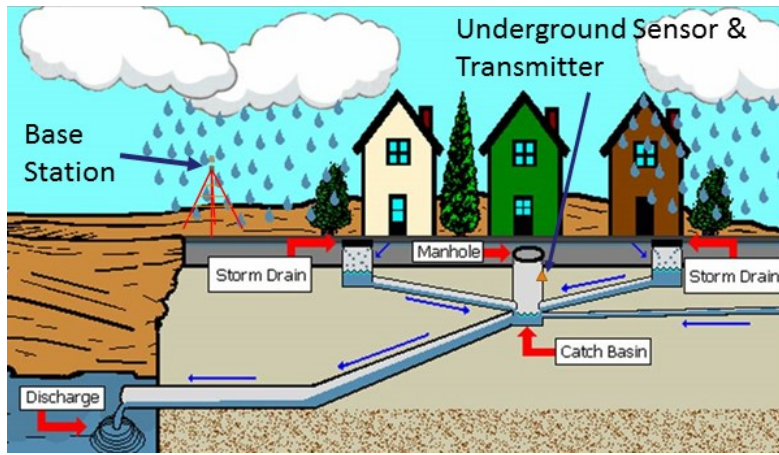
Figure 1. The architecture of urban underground IoT for wastewater